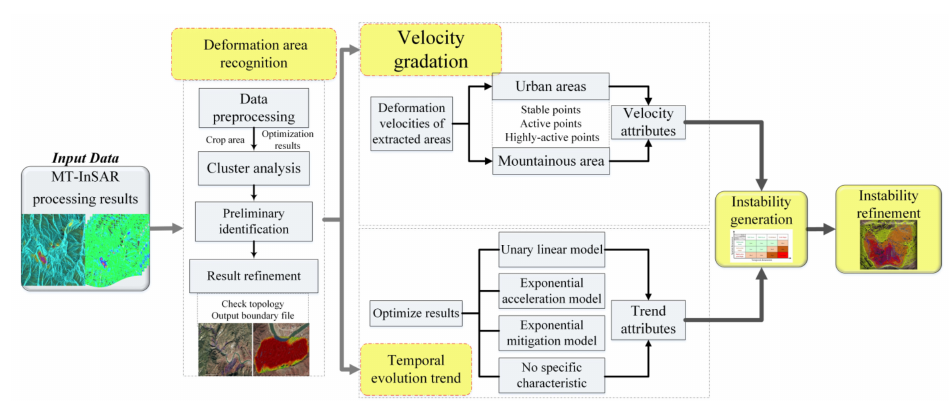
Figure 1. Flowchart of the improved